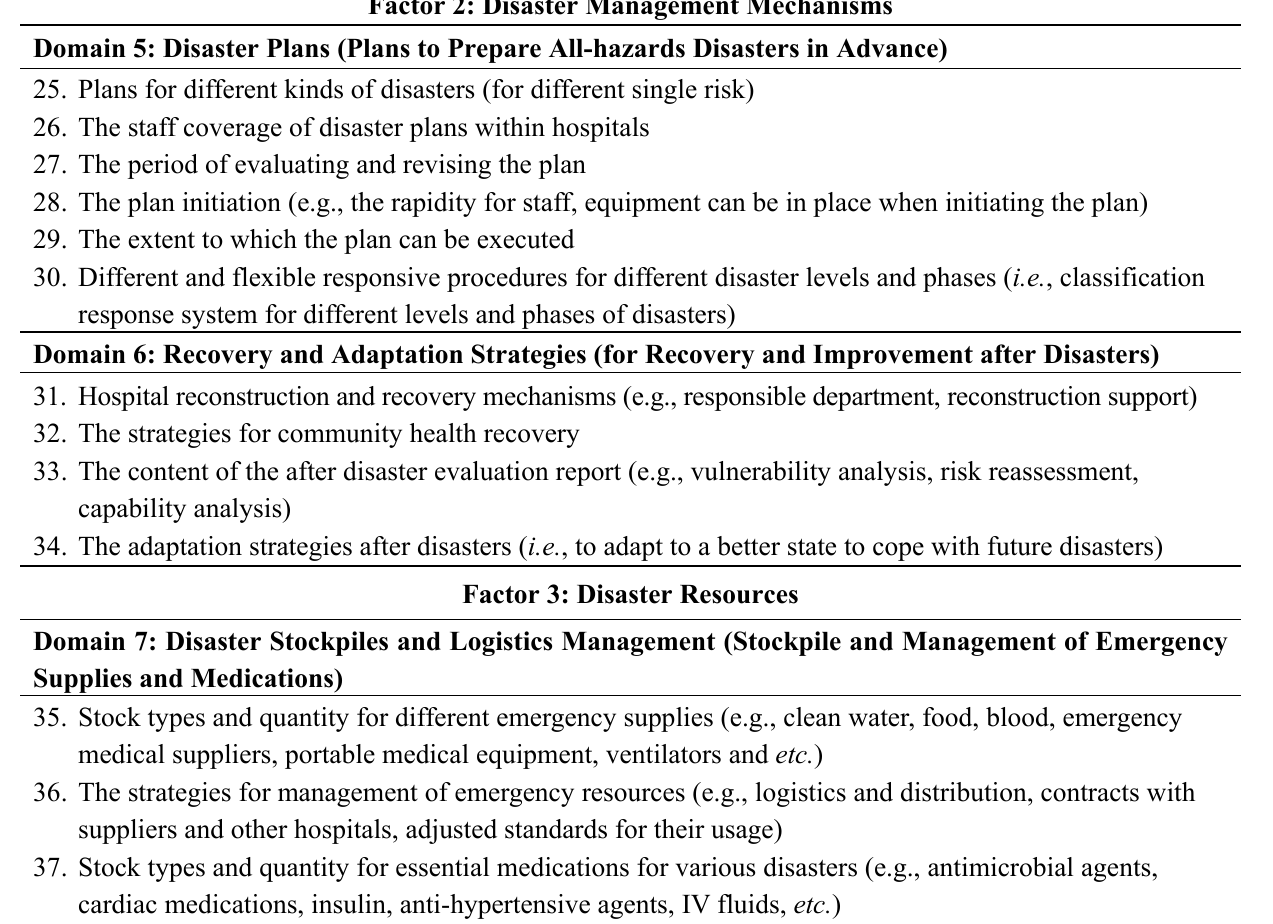
Table 2. Cont . Factor 2: Disaster Management